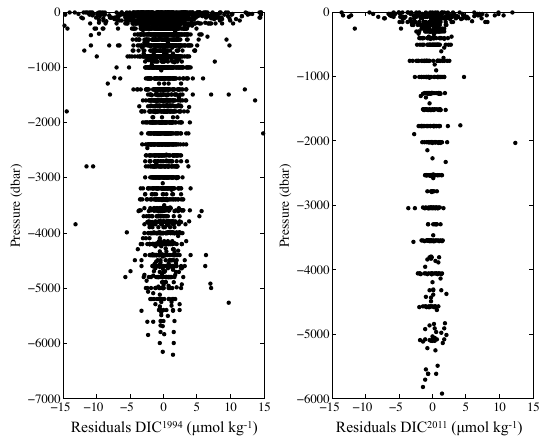
Figure 2. The residuals of the MLR fits of the (a) WOCE ’94 A17 and (b) GEOTRACES-NL (2010/2011) data